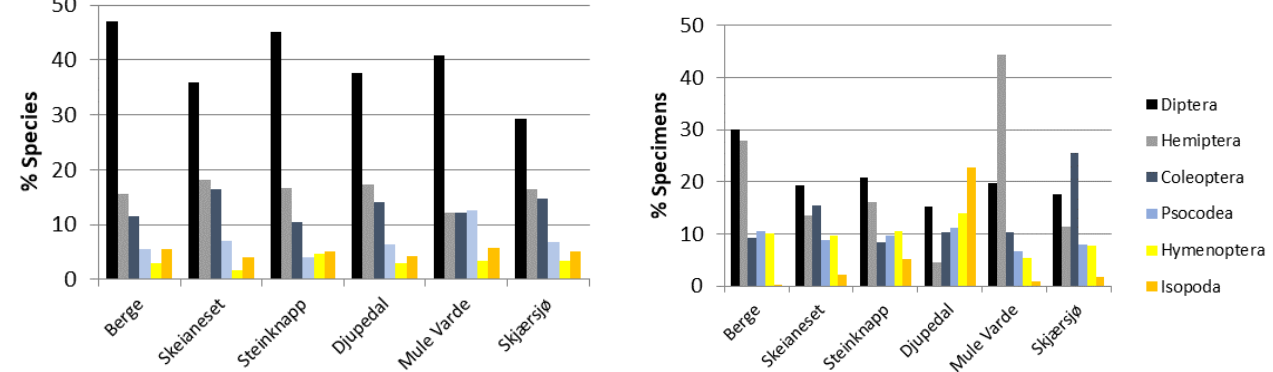
Figure 2. ( Left ) Percentage distribution of species (top six orders). ( Right ) Percentage distribution of specimens (top six orders). Table 2. Site diversity data. N Species = Number of species collected from the site. N Specimens = Number of specimens collected from the site. R α = Range of species numbers collected from any tree within the site. R Specimens = Range of specimens collected from any tree within the site. N Singletons = Number of species represented by one specimen only. Turnover = Whittaker’s β within the